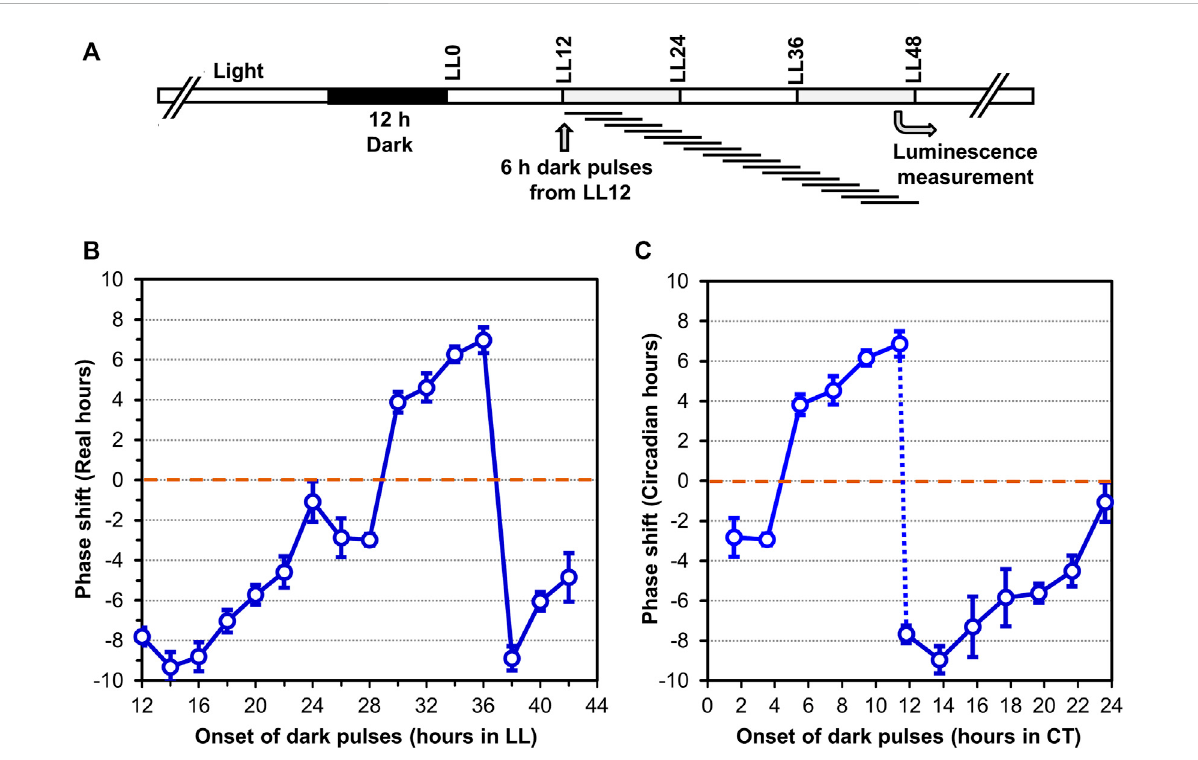
FIGURE 4 Phase Response Curve (PRC) to 6-h dark pulses of the luminescence rhythms reported by P psbA Ah ::luxAB in Synechocystis PCC 6803. (A) . Protocol of the experiment where 6-h dark pulses were applied at different time points in constant light (LL) beginning 12 h after the synchronizing 12-h dark exposure. After all dark pulses were completed (at LL48), the cultures were placed in the Kondotron turntable luminescence monitoring apparatusandthebioluminescencerhythmsweremonitoredforthenext7 days. (B,C) .Phaseshiftscausedbythe6-hdarkpulsesareplottedas a function of progressive time in constant light (Panel B) or as Circadian Time (=CT; Panel (C) . Advance versus delay phase shifts are determined on the basis of whether the shifted peak is 12 h or less earlier than the control (= Advance phase shifts, plotted as + values), versus 12 h or less later than the control (= Delay phase shifts, plotted as – values). Data are averages and standard deviations from six